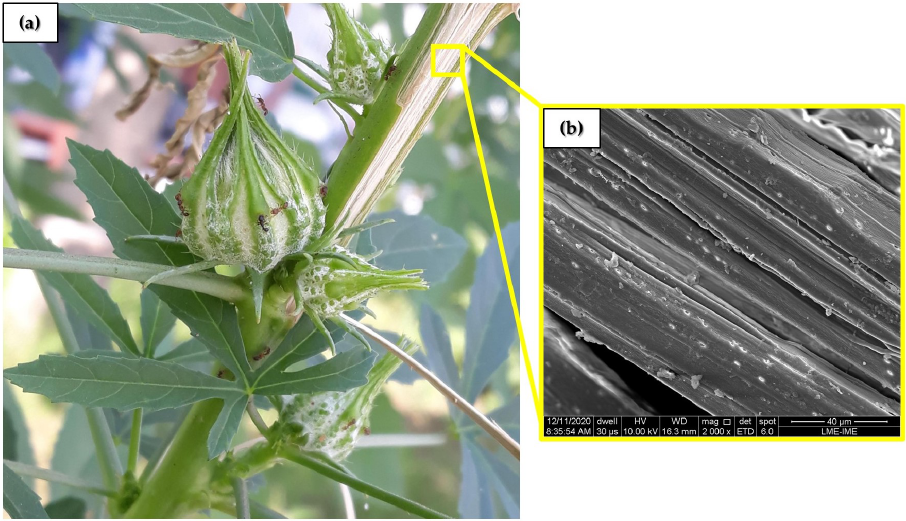
Figure 1. ( a ) Stem of the kenaf plant; ( b ) SEM of the kenaf fiber longitudinal